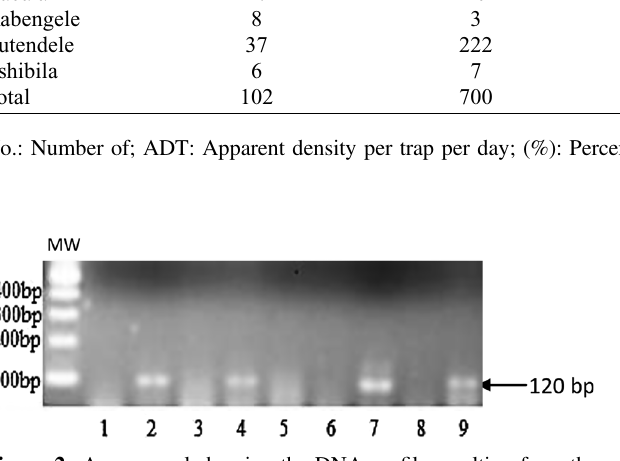
Figure 2. Agarose gel showing the DNA pro fi le resulting from the molecular identi fi cation of S. glossinidius using pSG2 primers. Lane 1: negative control; lane 9: positive control; lanes 2, 4 and 7: samples positive for S. glossinidius ; Lane 3, 5, 6 and 8: samples negative for S. glossinidius . MW: 100 bp DNA